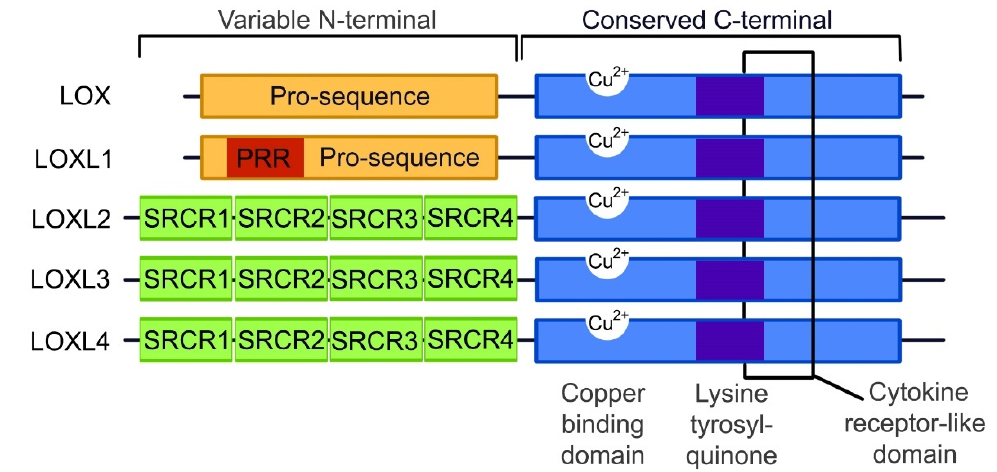
Figure 1. The structure of the LOX and LOXL1–4 proteins. The C-terminal is conserved between all the LOX protein family members, containing a copper binding domain, a lysine tyrosylquinone cofactor residue and a cytokine receptor domain. At the N-terminals, LOX and LOXL1 contain pro-sequences, with LOXL1 containing a proline-rich region (PRR), while LOXL2–4 contain scavenger receptor cysteine-rich domains (SRCR) within the N -terminal. (Image adapted from Wu 2015 [50]). LOX exists in an inactive form, which is mainly located in the cytosol, and upon activation, it is